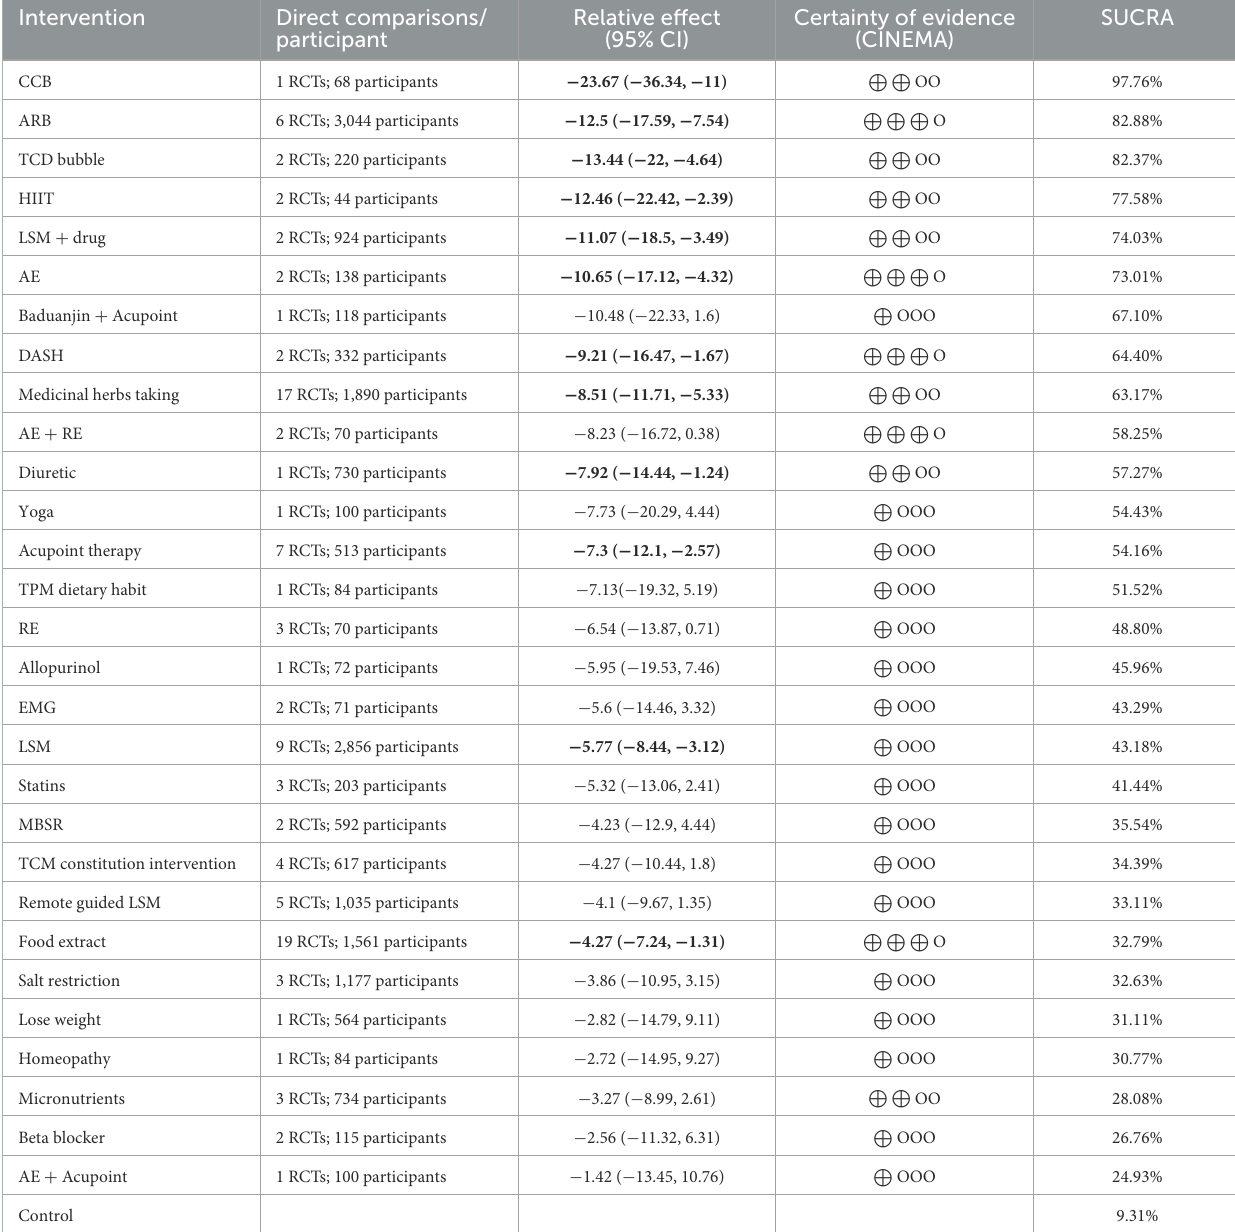
TABLE 1 Summary of findings on the efficacy of various interventions to reduce SBP. Intervention Direct comparisons/ participant